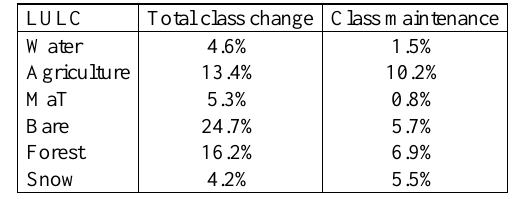
Table 2. Change and maintenance of LULC compared to the total quantity of pixels. Example: 4.6% of other classes of LULC became water bodies, while 1.5% have maintained in the original